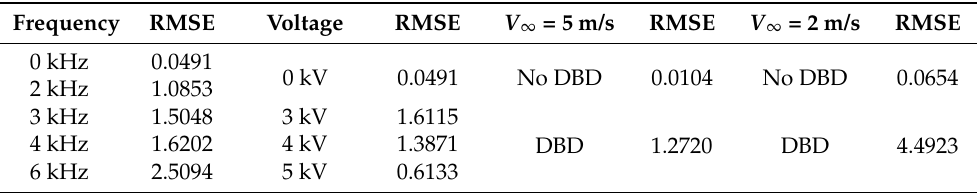
Table 2. RMSE of normalized wall shear stress with different